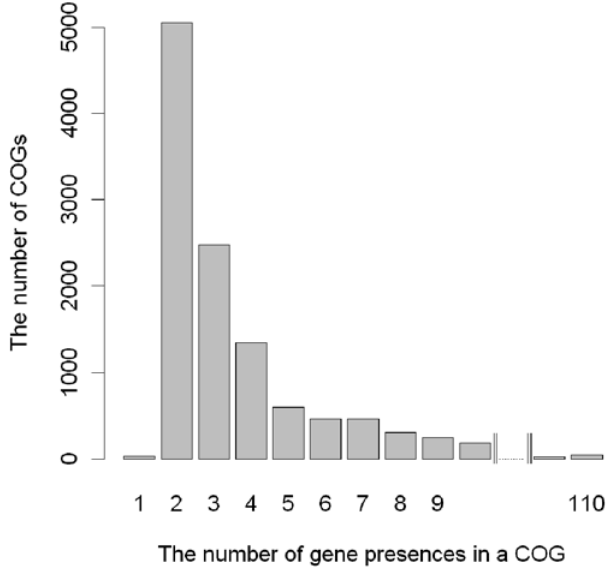
Figure 1. The distribution of the COG-06 dataset by the number of genomes that encode a representative of this COG (i.e., by the number of coordinates set at 1 in the phyletic vector corresponding to each COG). Only 1,021 proteins (7%) are encoded in more than half of the 110 genomes.